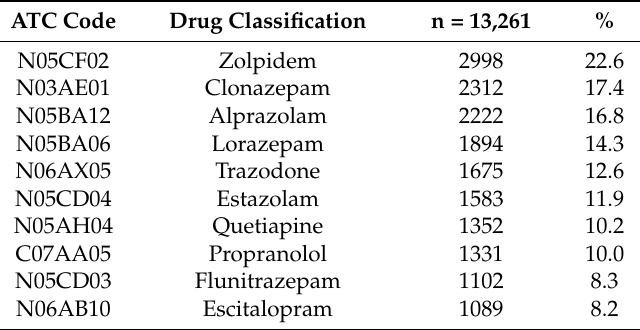
Table 4. The prescription of drugs by ATC 5th